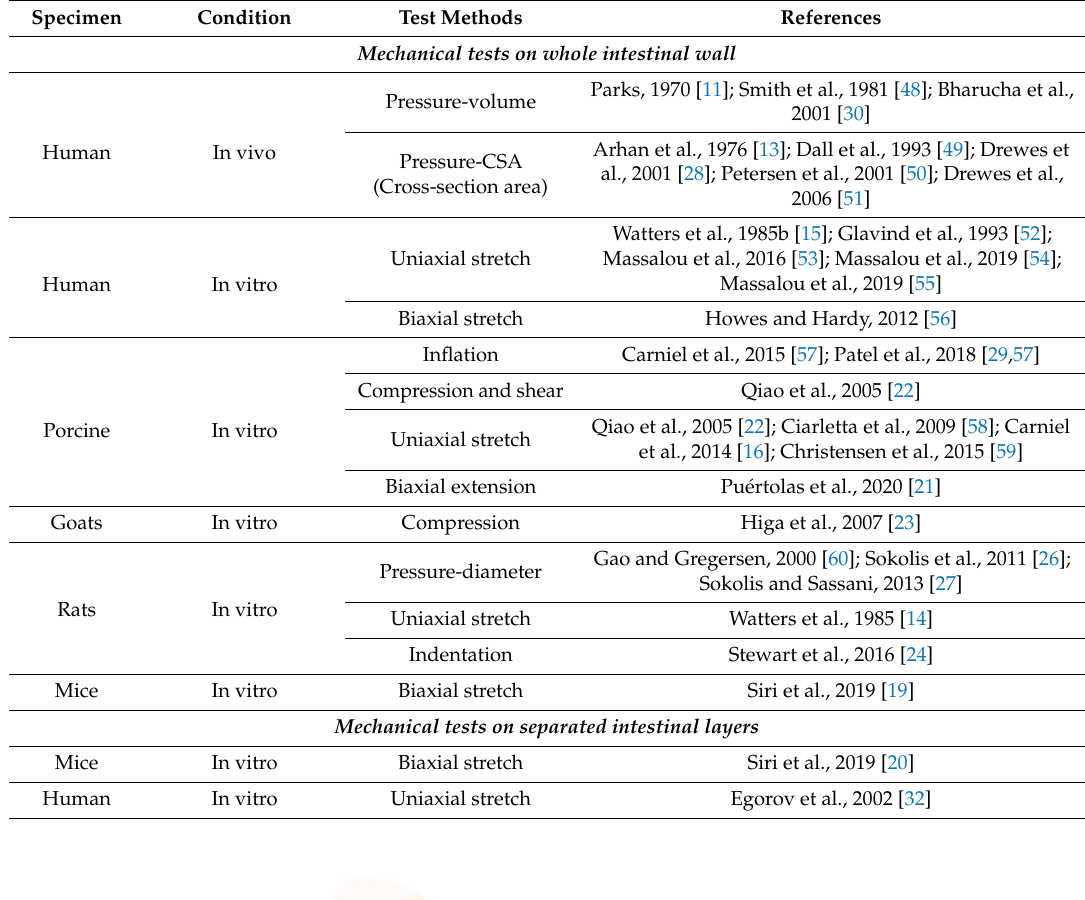
Table 1. Mechanical tests on large intestinal tissues.